Question: What form of chart is displayed?
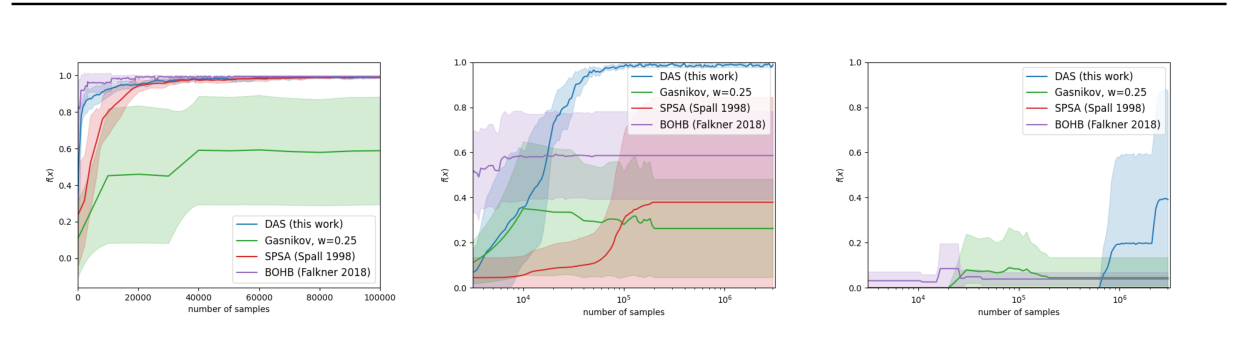
Answer: line